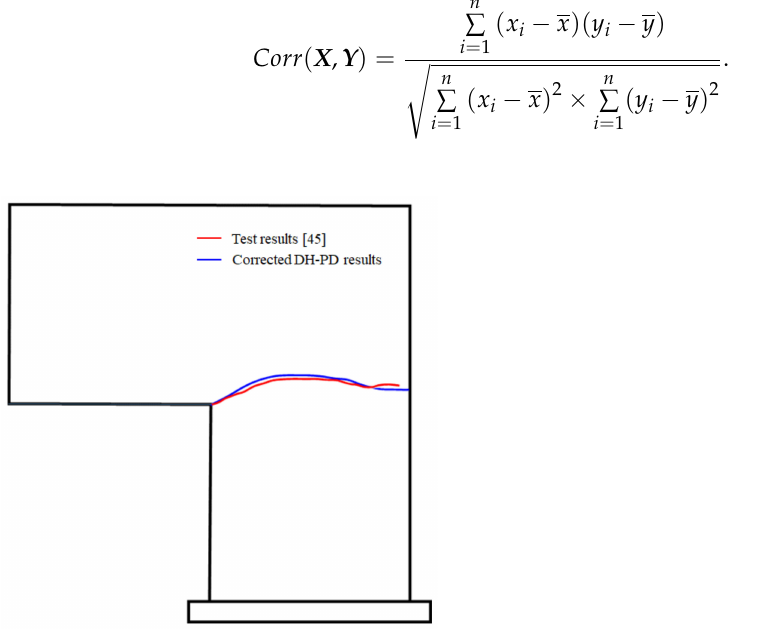
Figure 16. Comparison of the numerical and experimental crack propagation paths [45]. In Equation (17), x and y are the average values of the two data sets,